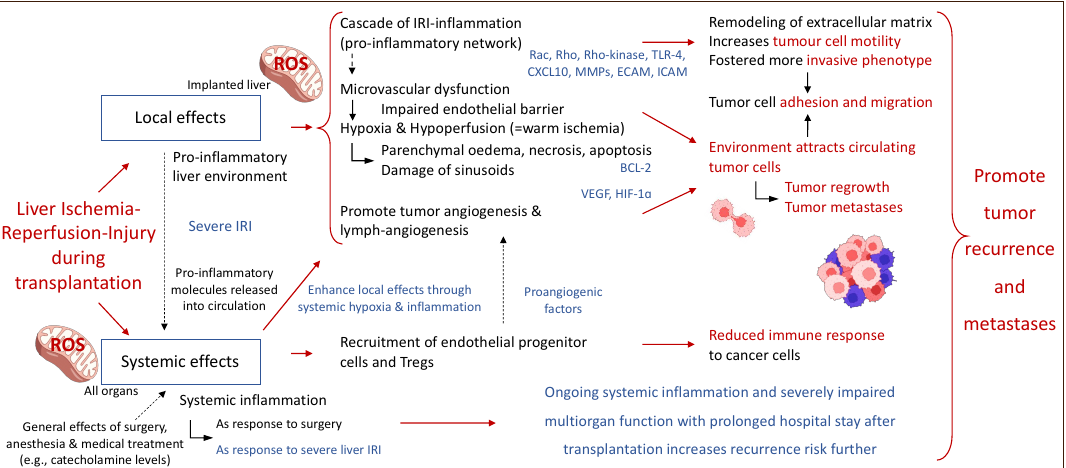
Figure 3. Perioperative events with an impact on the fate of residual cancer cells after liver transplantation. Local and systemic effects establish a complex interplay and contribute to cancer recurrence involving the entire system of the liver recipient. Rac: Rho family of nucleotide guanosine triphosphate hydrolase enzymes; Rho: Rho family of nucleotide guanosine triphosphate hydrolase enzymes; TLR-4: toll-like receptor-4; CXCL10: C-X-C motif chemokine ligand; MMPs: metalloproteinase; ECAM: epithelial cell adhesion molecule; ICAM: intercellular adhesion molecules; BCL-2: B-cell lymphoma 2 gene; VEGF: vascular endothelial growth fact; HIF-1 : hypoxia-inducible factor 1 . This figure was designed with the support from biorender.com (accessed on 15 June 2022).